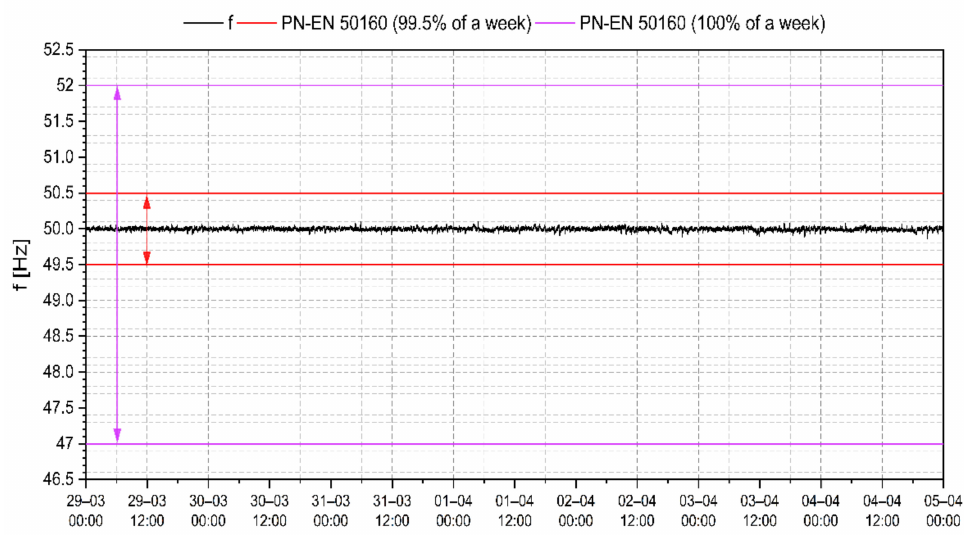
Figure 5. Power frequency variation during the measurement week; colored lines indicate the